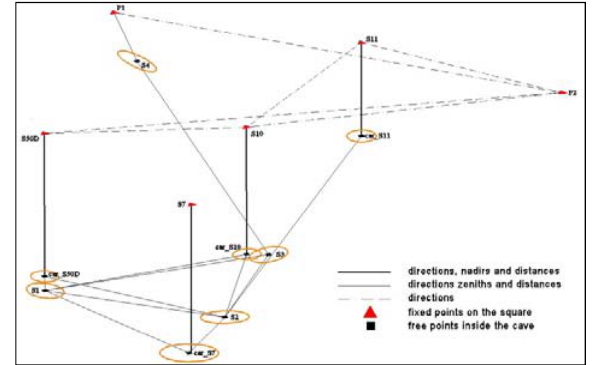
Figure 6. Sketch of the local network a set of double coordinates. This allowed us to determine the Helmert transformation parameters, useful to convert the point clouds coordinates from the scans reference frame to the ROMA40 one.